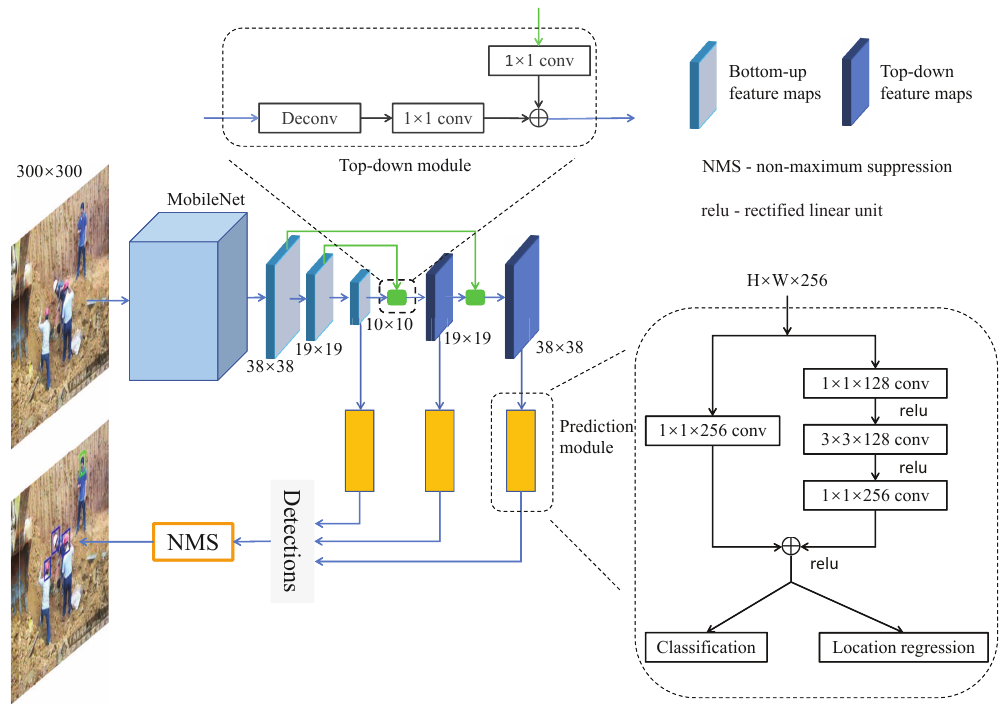
Figure 1. Architecture of the proposed network for detecting and classifying no_hardhat and hardhat